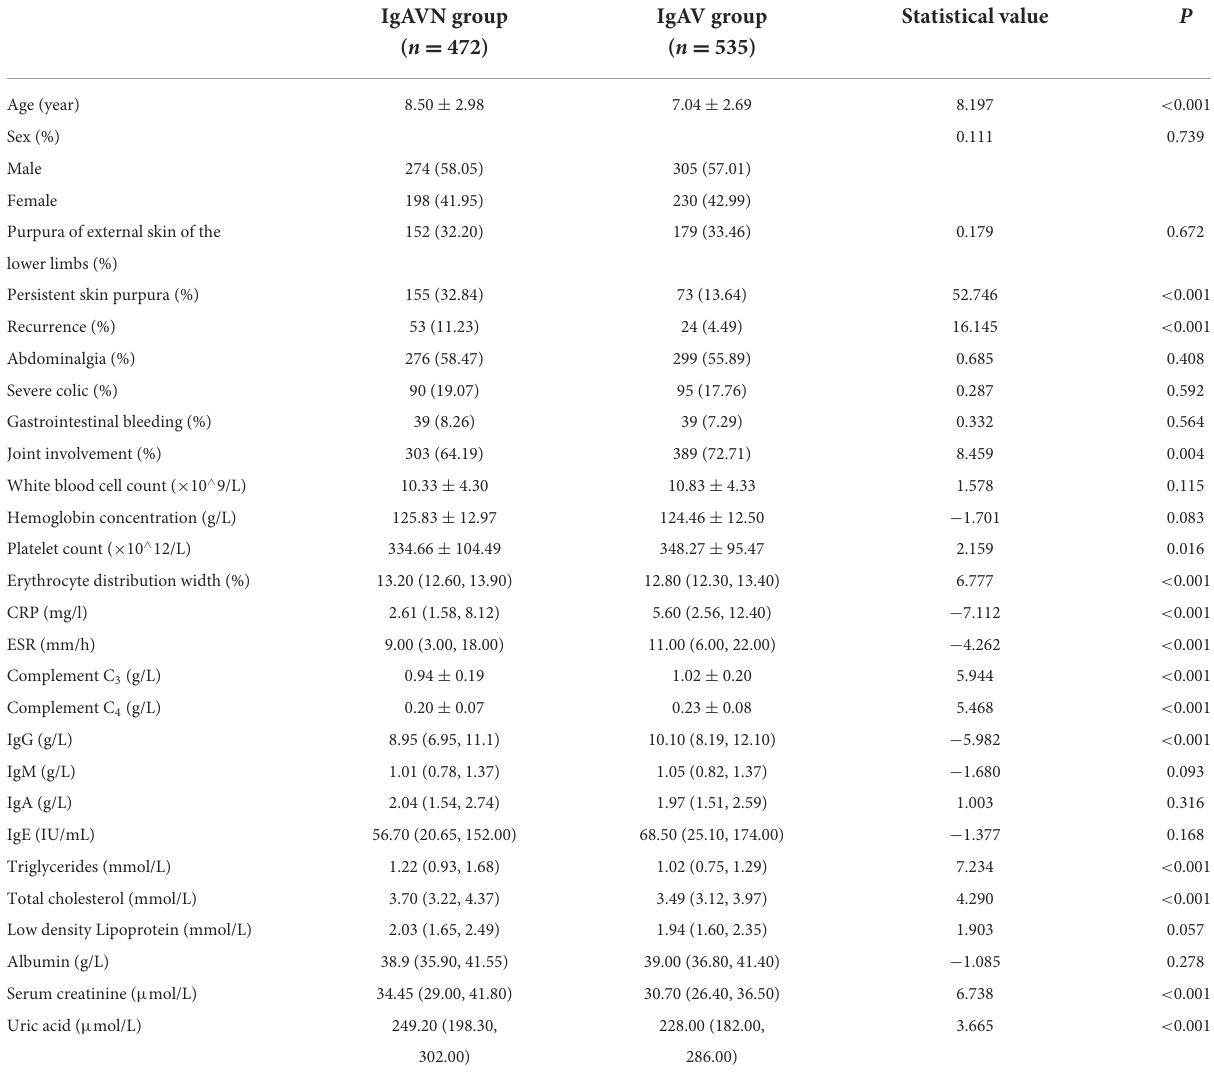
TABLE 1 Univariate analysis of observation indicators in 1,007 children with IgAV.